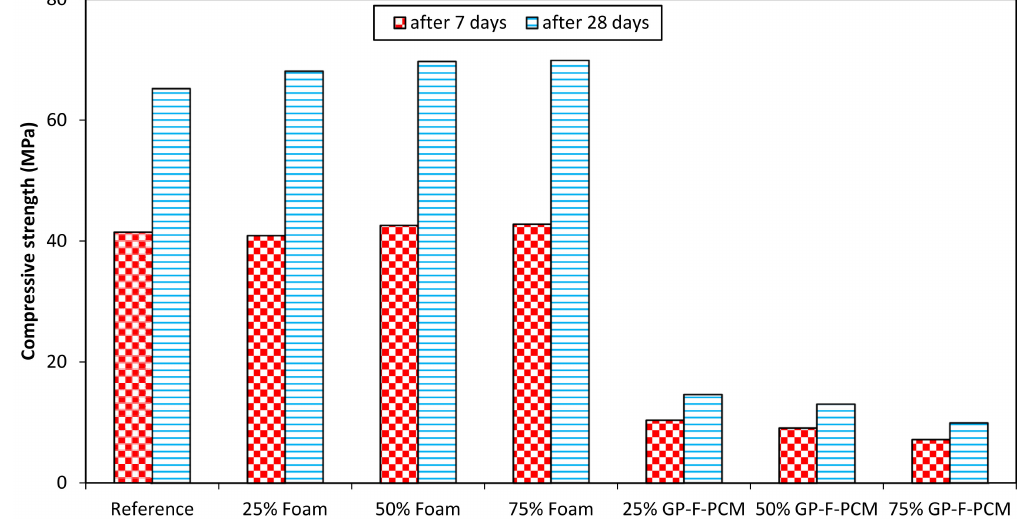
Figure 10. Compressive strength test